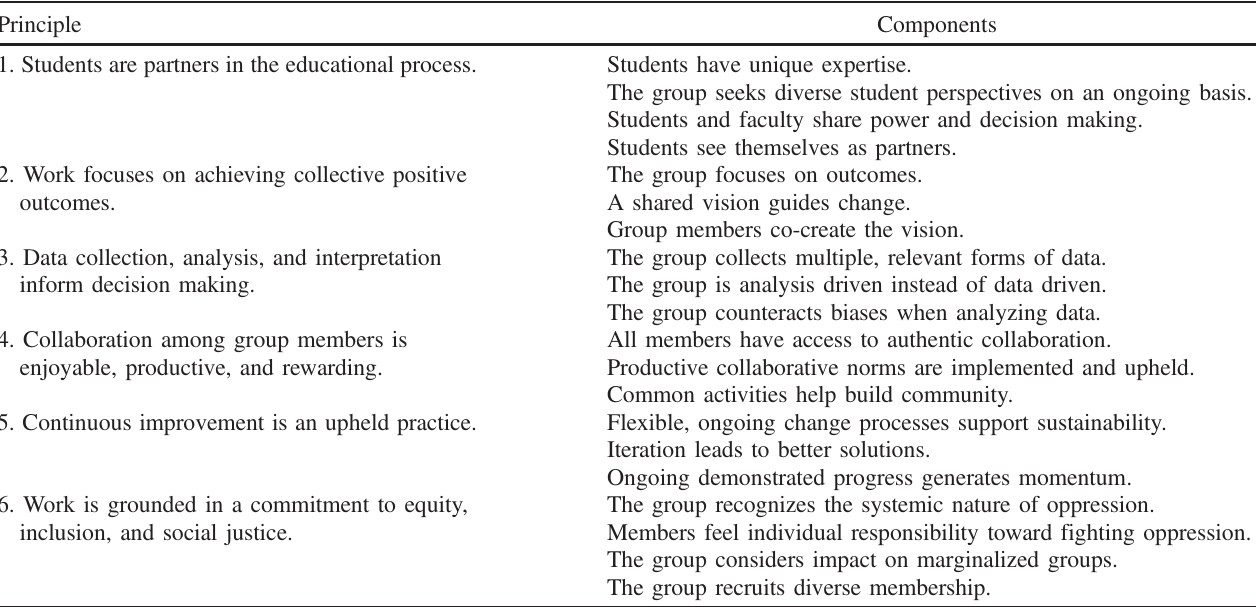
TABLE I. Summary of each principles ’